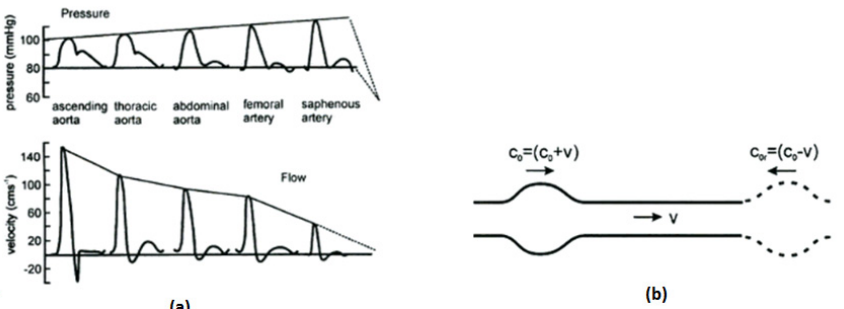
Figure 3. ( a ) Pressure and velocity waveforms in arteries as they travel away from the heart adapted from measurements made in dogs. The waveforms show the effects of amplification of the pressure wave; ( b ) forward and reflected pulse wave velocity relative to the velocity of blood flow with rotation speed ( ω ).